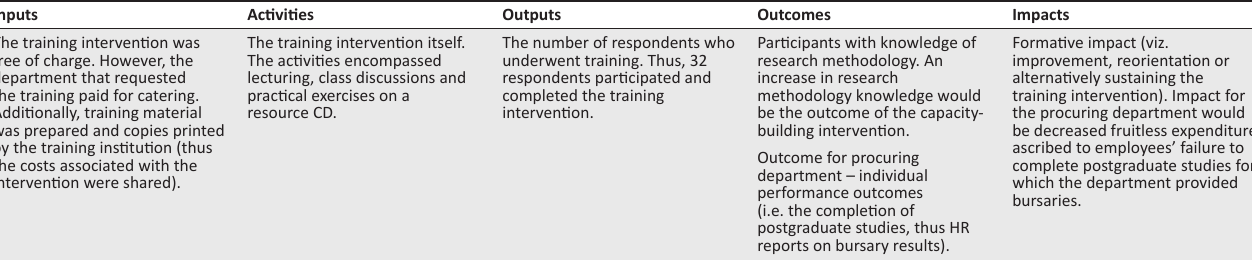
TABLE 1: Training evaluation logical framework. Inputs